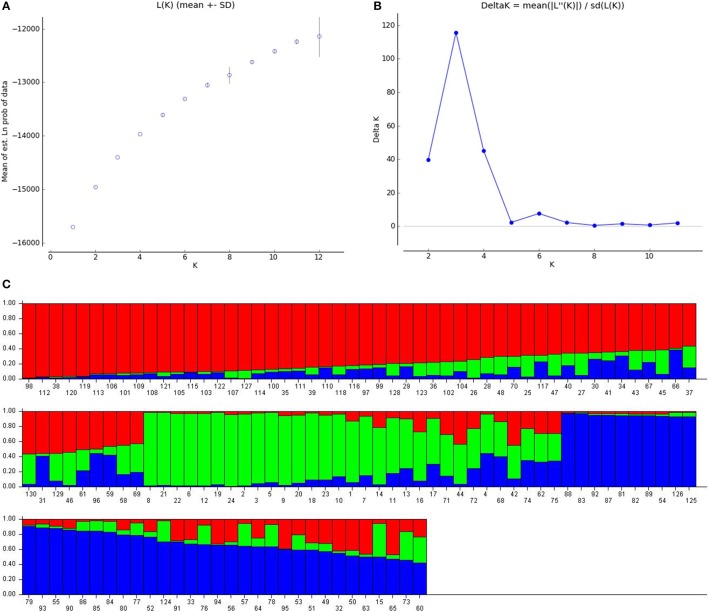
Population stratification of pearl millet association mapping panel (A) LnP(D), the log likelihood values from k = 1 to 12. (B) Delta K, rate of change from 2 to 11. (C) Inferred population structure (K = 3, each color represents one sub-population).